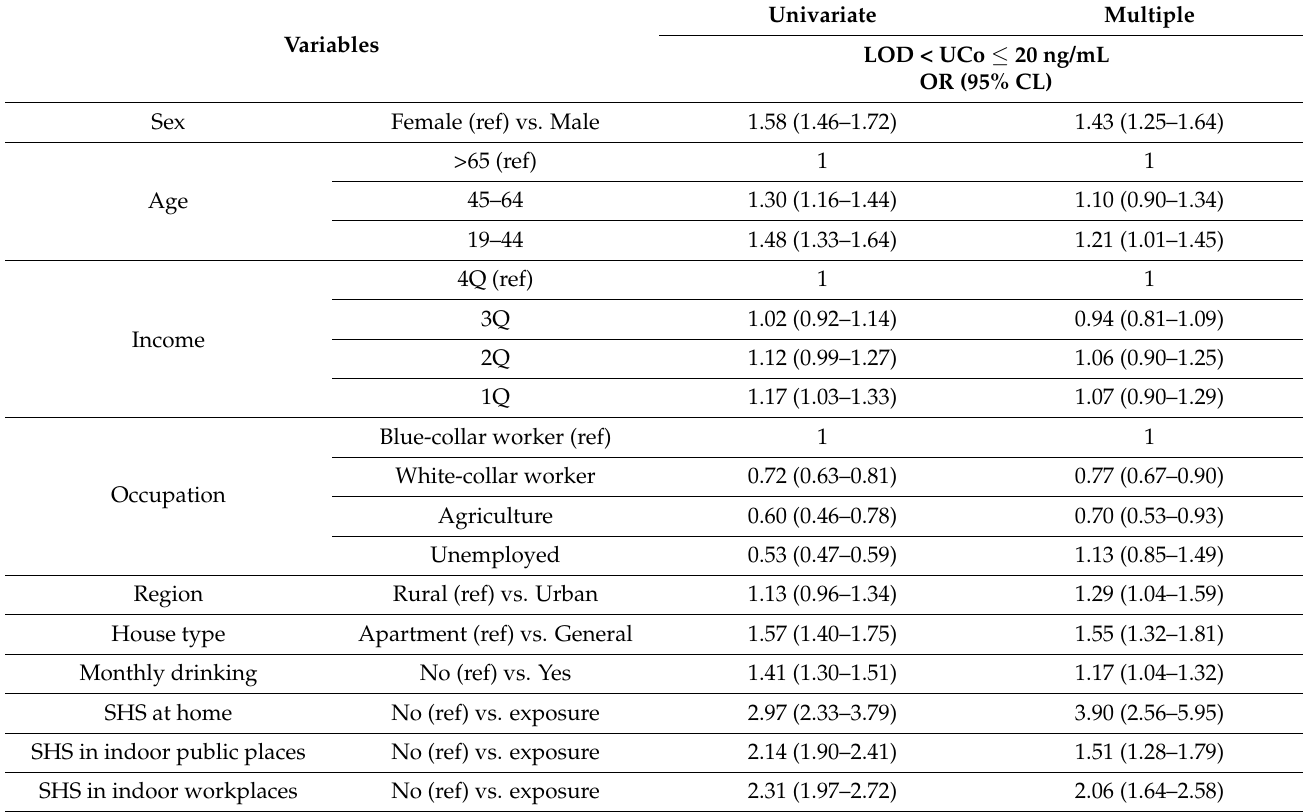
Table 4. Factors associated with SHS exposure with identified cotinine levels by multiple logistic